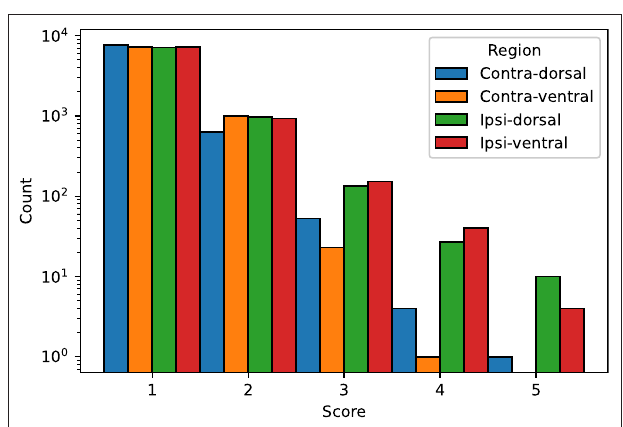
FIGURE 7 | Qualitative score distribution for both hippocampi, divided for the dorsal and ventral aspects of the contralateral and ipsilateral hippocampus. Counts are reported on a logarithmic scale. The overwhelming majority of hippocampal regions were labeled as requiring no corrections (1), followed by regions requiring minor corrections only (2).